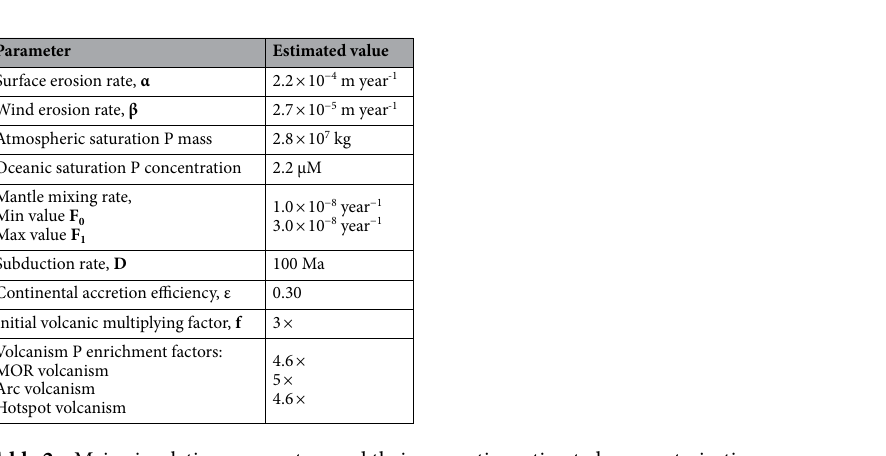
Table 2. Main simulation parameters and their respective estimated parameterizations.